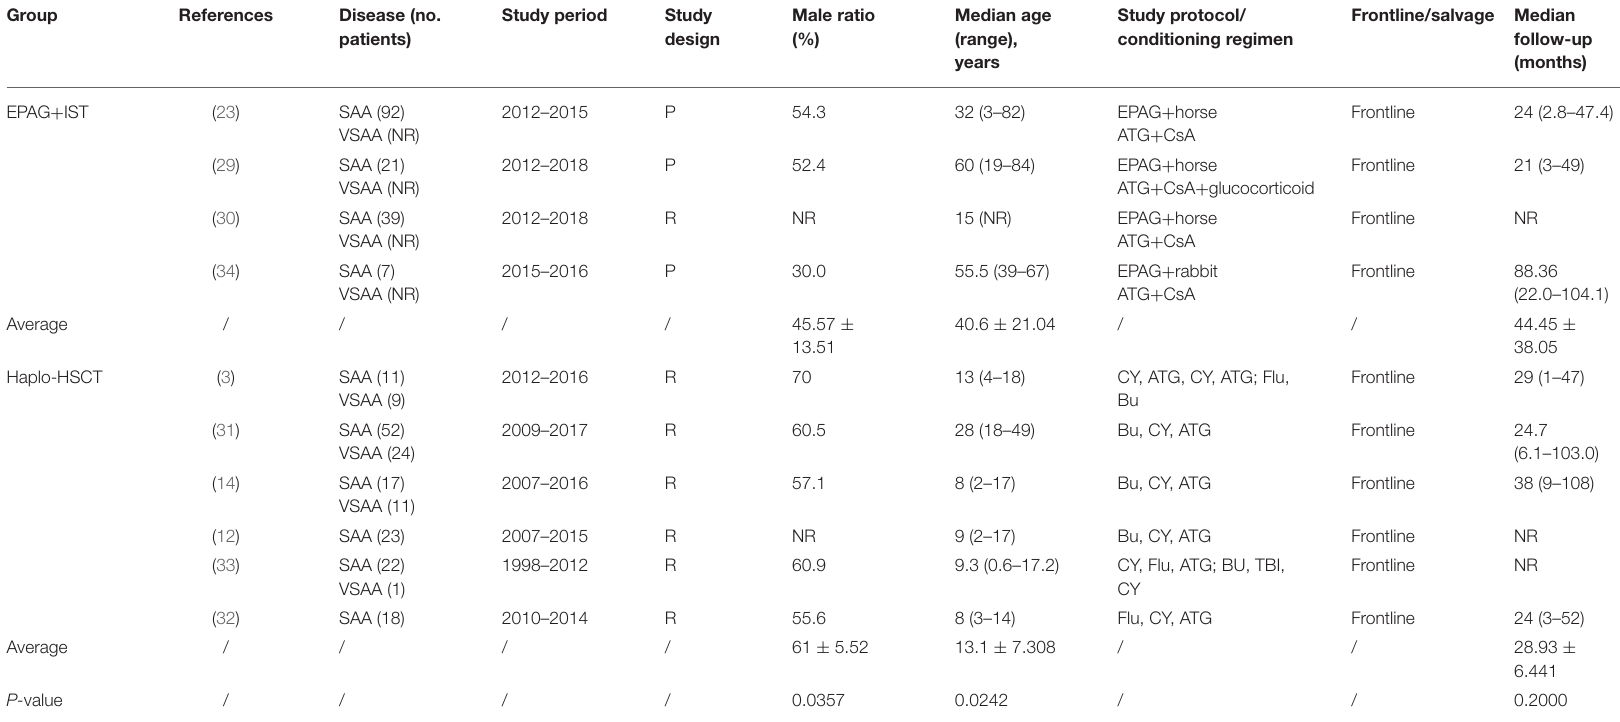
TABLE 1 | The characteristics of included